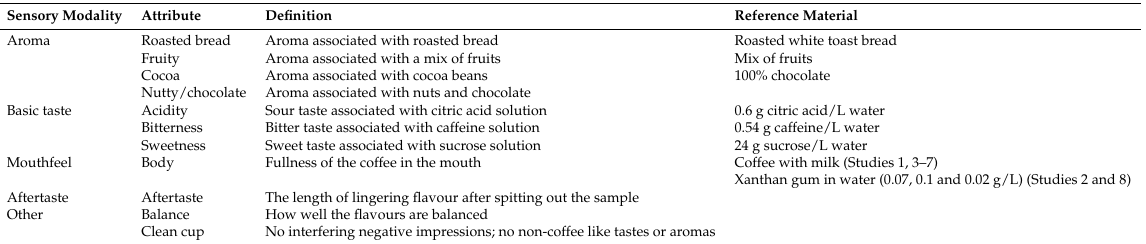
Table 3. Sensory attributes, definitions, and reference material used for assessor training across all